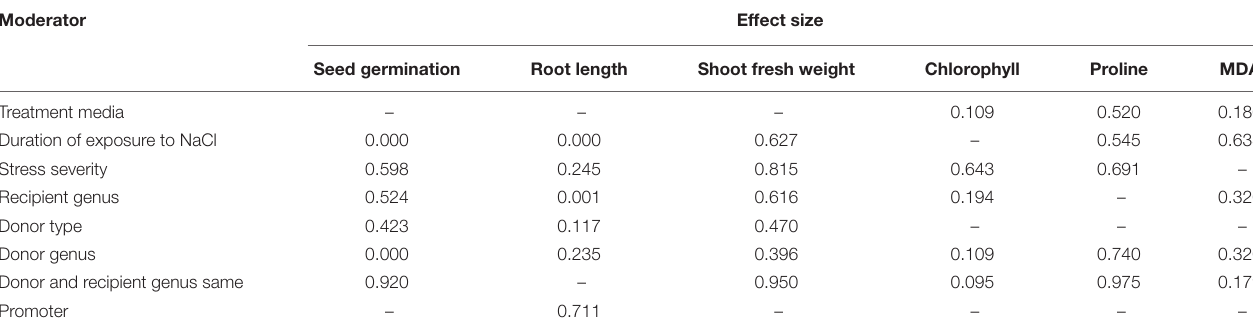
TABLE 3 | Categorical moderators examined for the six summary effects of CIPK-overexpression that were significantly different from zero Heterogeneity p -values ( p- hetero ) are shown here.